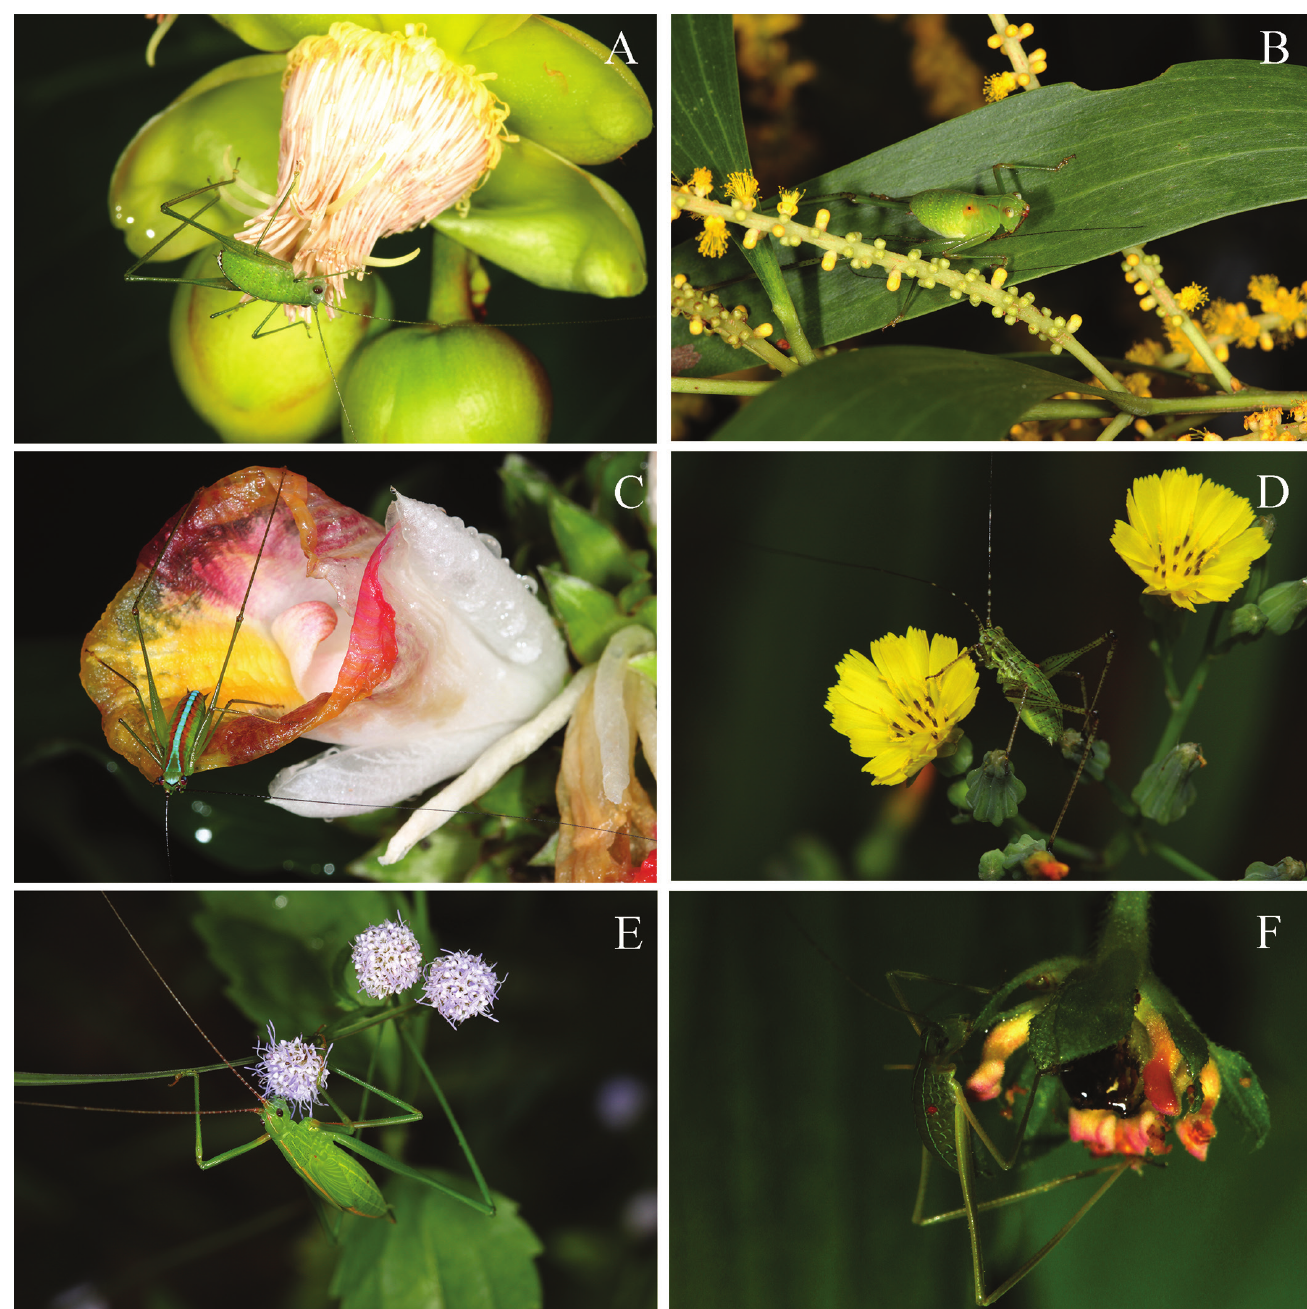
Fig. 4. Examples of unidentified Phaneropterinae nymphs visiting flowers of various plants: A. Dillenia suffruticosa in Singapore, B. Aca- cia auriculiformis in Singapore, C. Costus lucanusianus in Singapore, D. Youngia japonica in Bukit Larut, E. Praxelis clematidea in Sakaerat, and F. Lantana camara in